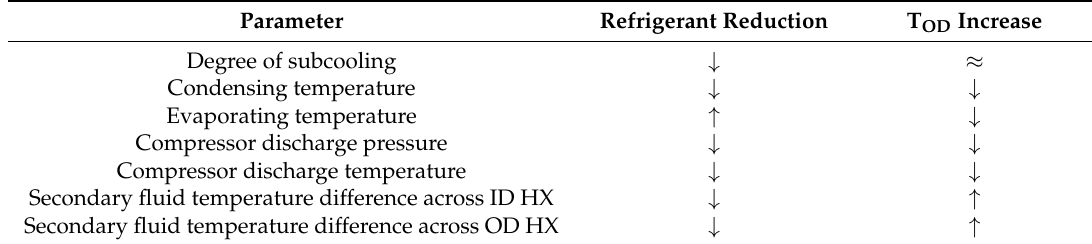
Table 3. Parameter trend and characteristics of the water-to-water heat pump in heating mode. Parameter Refrigerant Reduction T OD Increase Degree of subcooling ↓ ≈ Condensing temperature ↓ ↓ Evaporating temperature ↑ ↓ Compressor discharge pressure ↓ ↓ ↓